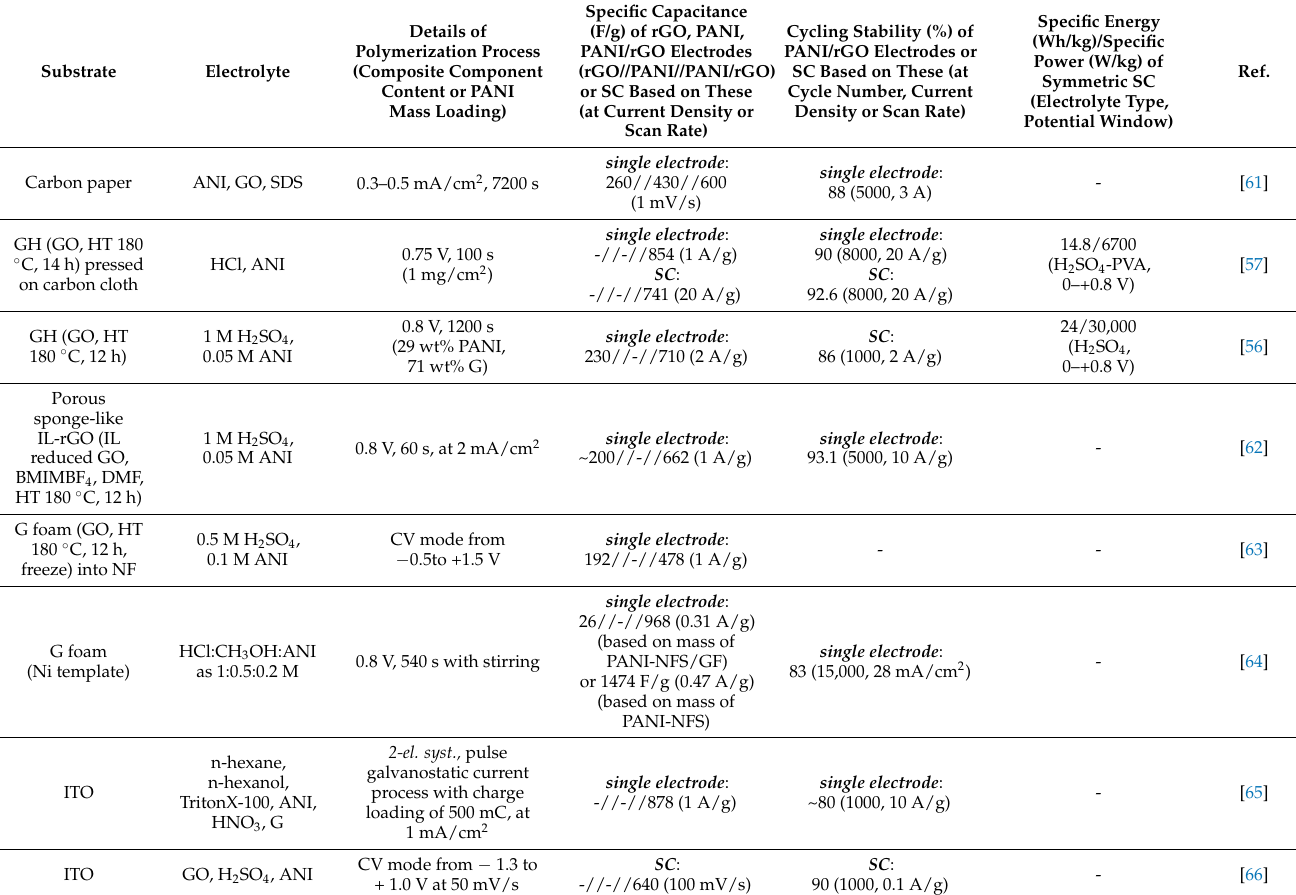
Table 3. Available data of the specific capacitance, cycling stability and summary processing details of mixed PANI/rGO composite single electrodes measured in three-electrode systems or full SC ordered by type of the used